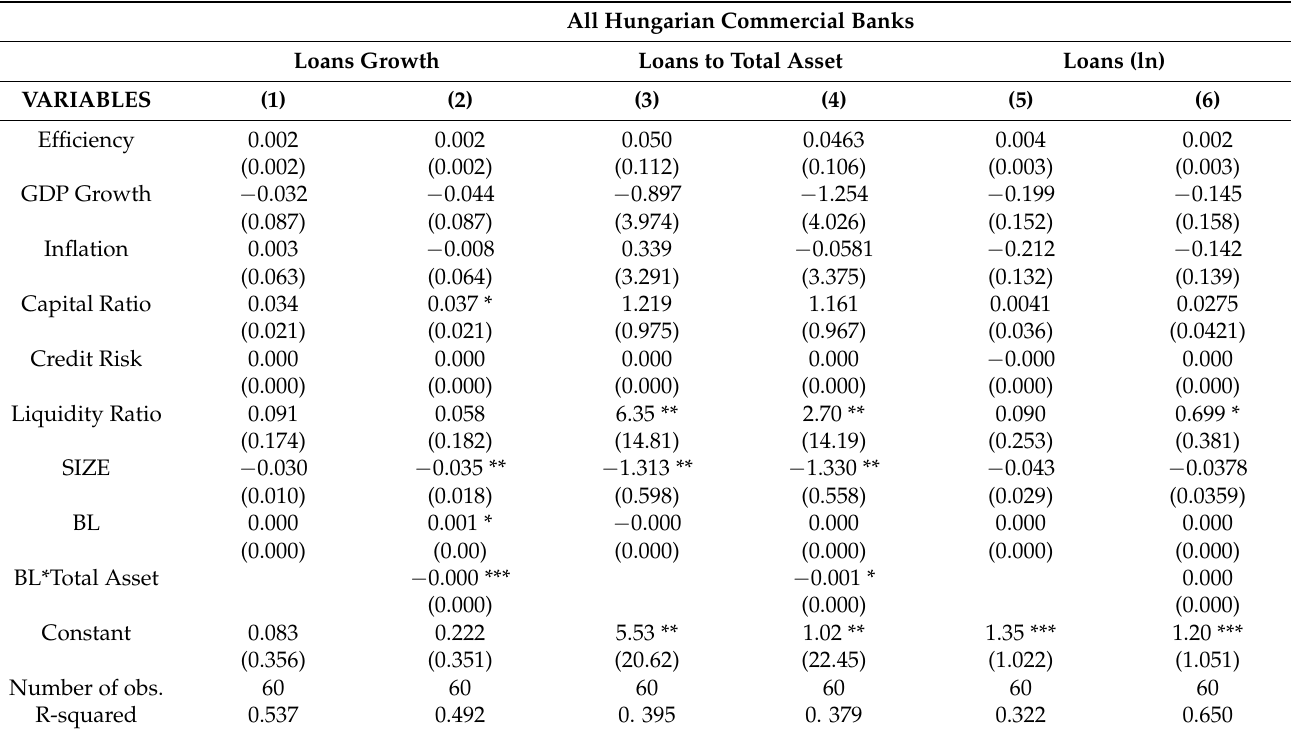
Table 4. Data presenting estimates based on GLS regressions with a random effect on all Hungarian commercial banks. Symbols *, **, and *** represent statistical significance at the levels of 10%, 5%, and 1%,